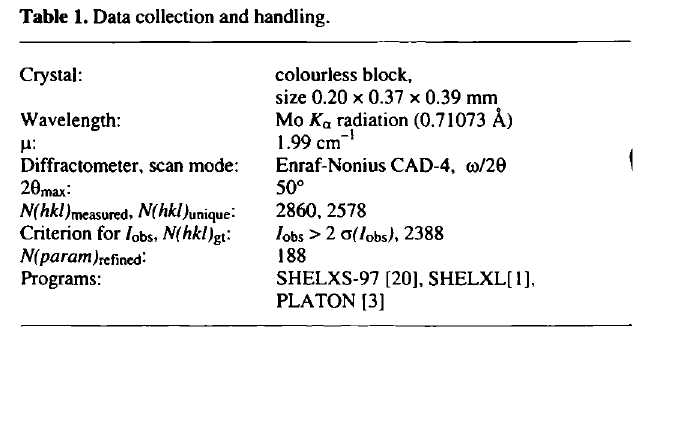
Table 1. Data collection and